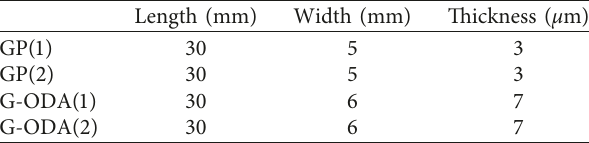
Table 1: Dimensions of GP and G-ODA